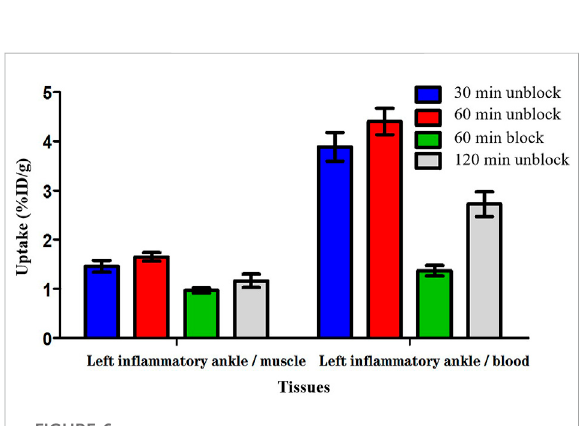
FIGURE 6 Theradioactivityratiosoftheleftin fl ammatoryankletoblood (LIA/B)andtheleftin fl ammatoryankleto muscle(LIA/M)atvarious times post-injection based on biodistribution results of 18 F-VUIIS1008.